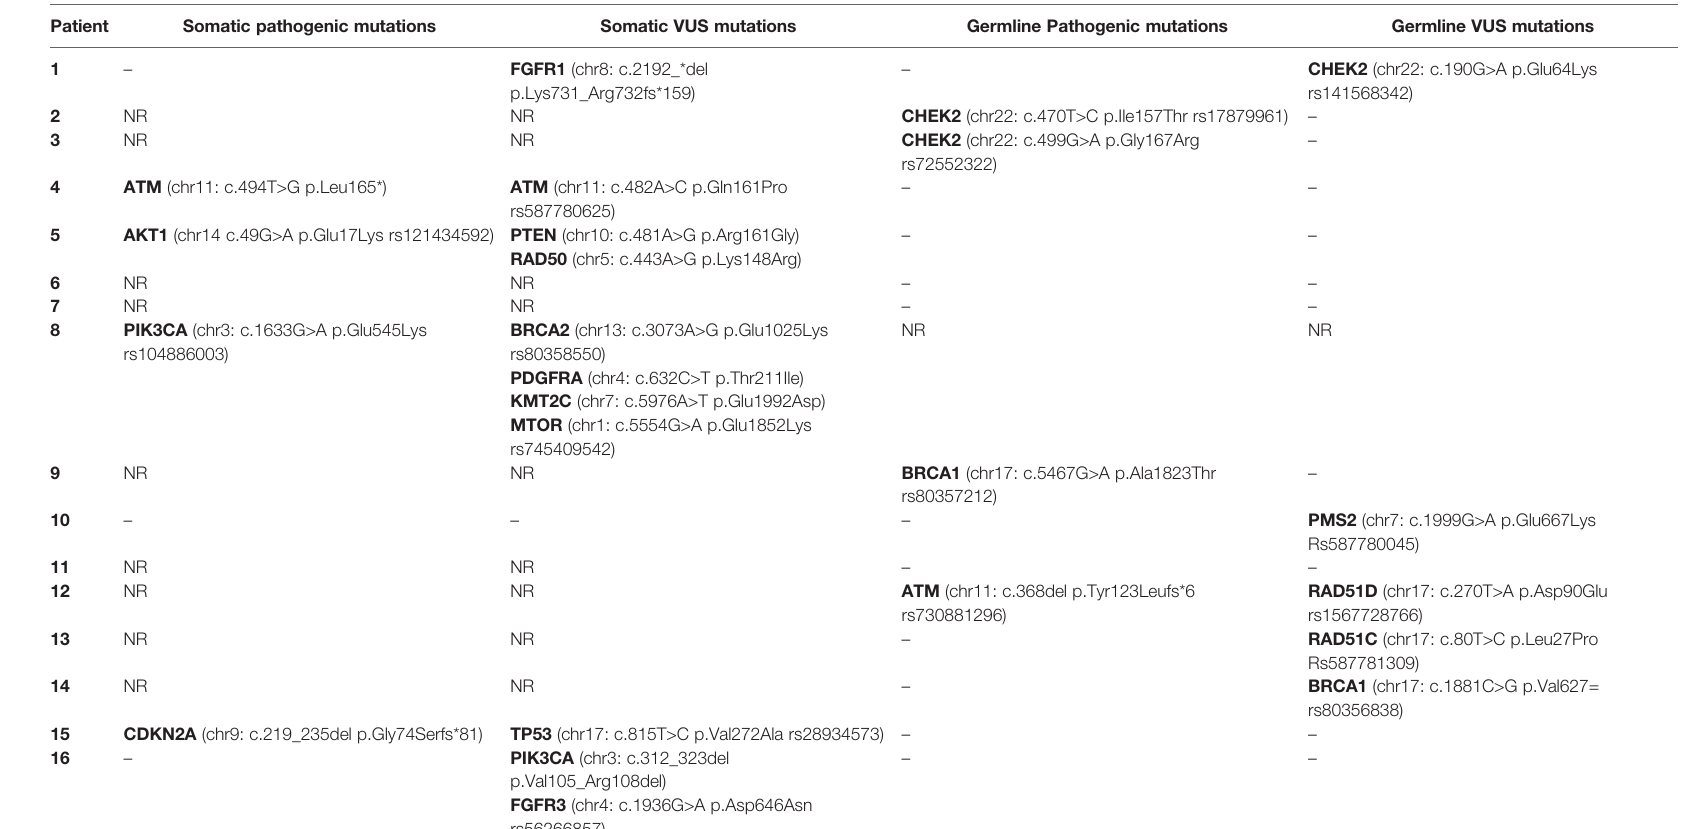
TABLE 6 | Somatic and germline mutations of old women (>40) with breast cancer as determined by NGS.